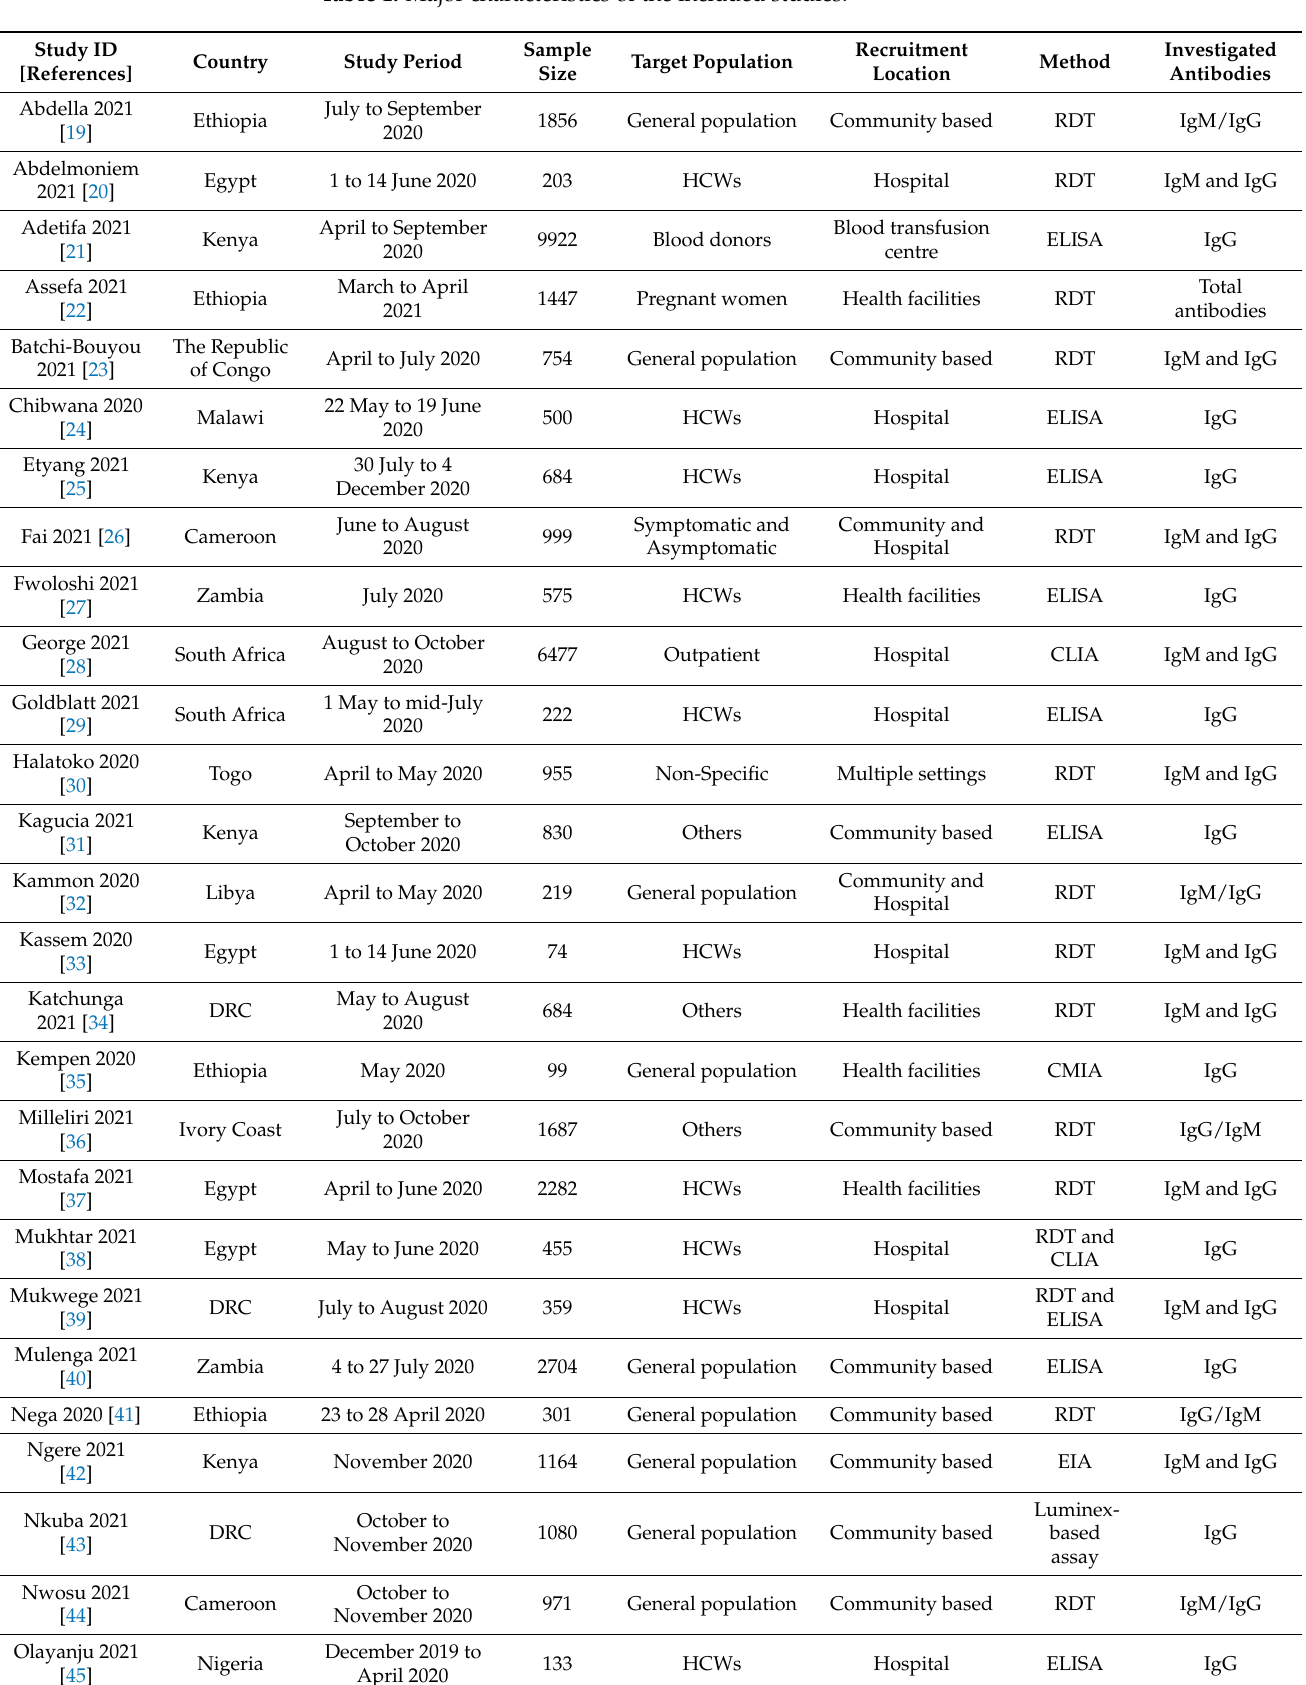
Table 1. Major characteristics of the included